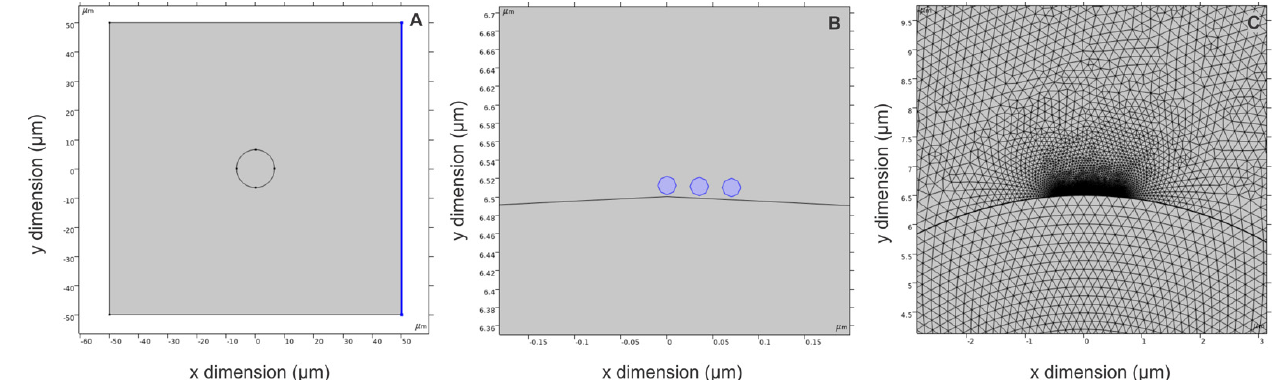
Figure 5. FEM model in COMSOL environment, where ( A ) cell model inside a cuvette; ( B ) model of gold nanoparticles in close proximity with cell membrane; ( C ) generated mesh structure.